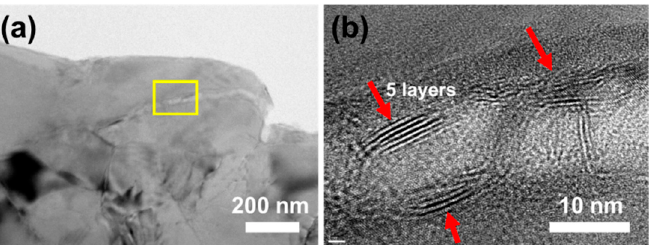
Figure 2. SEM images of ball-milled powders. ( a ) Pure Al, ( b ) 0.5 wt.% FLM/Al, ( c ) 1.5 wt.% FLM/Al, and ( d ) the amplification of the yellow box in ( c ).